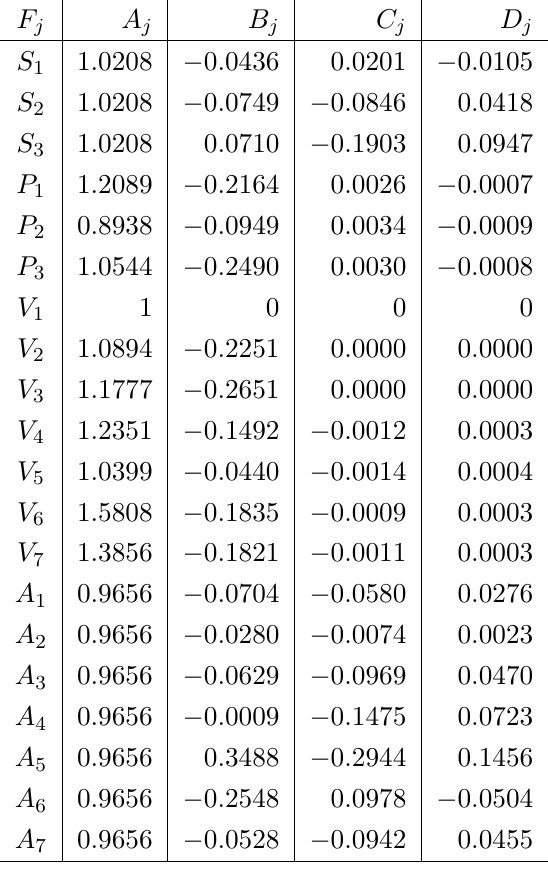
Table 2 . Coe(cid:14)cients of the expansion in powers of ( w (cid:0) 1) of F j =V 1 , see eq. (2.3). at or near zero recoil